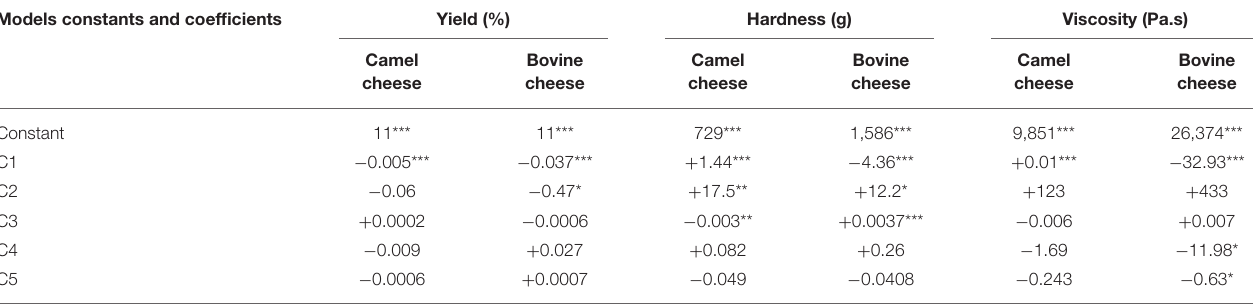
Camel Bovine Camel Bovine Camel Bovine cheese cheese cheese cheese cheese cheese